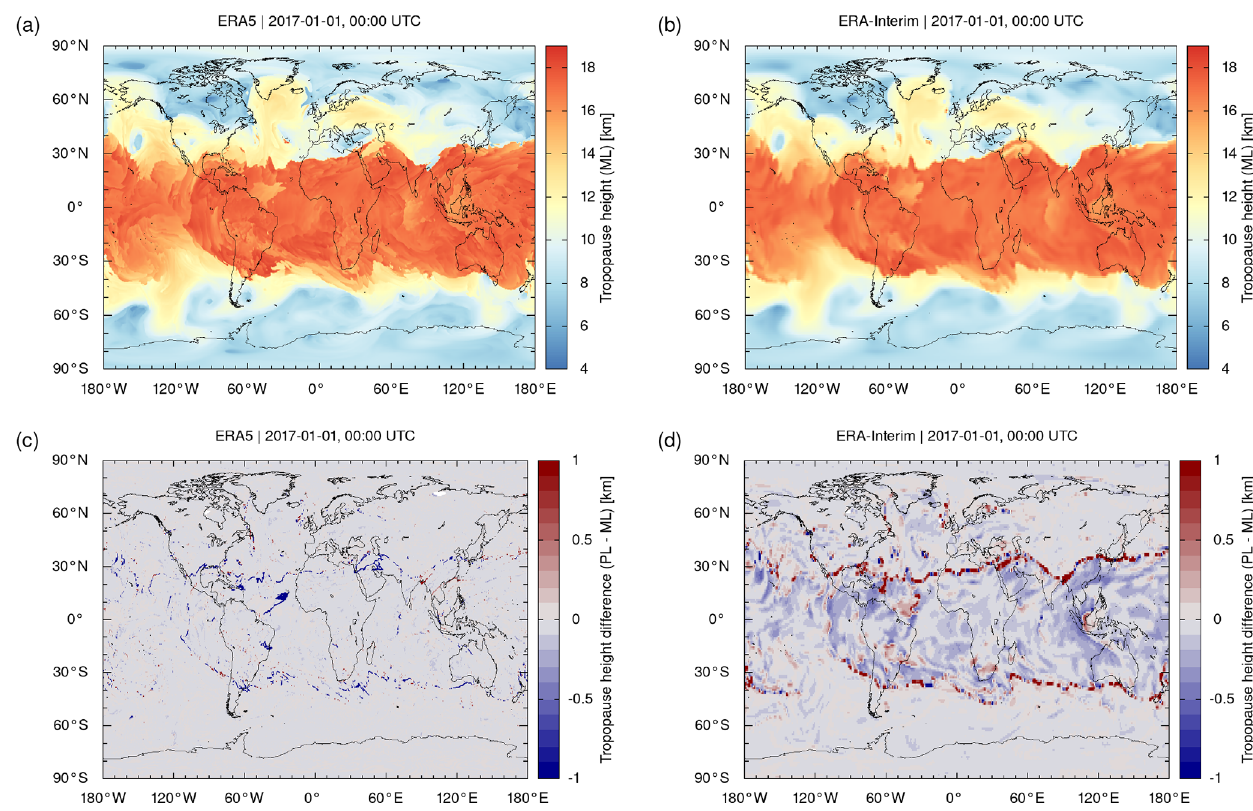
Figure A1. Global maps of tropopause geopotential heights from (a) ERA5 and (b) ERA-Interim as derived from reanalysis model level (ML) data. The corresponding pressure level (PL) data are shown in Fig. 2. Differences between pressure and model level data (PL − ML) are shown in panel (c) and (d) , respectively. Note that the color bar ranges for the differences are restricted to ± 1km to make smaller differences visible. The data refer to 1 January 2017,